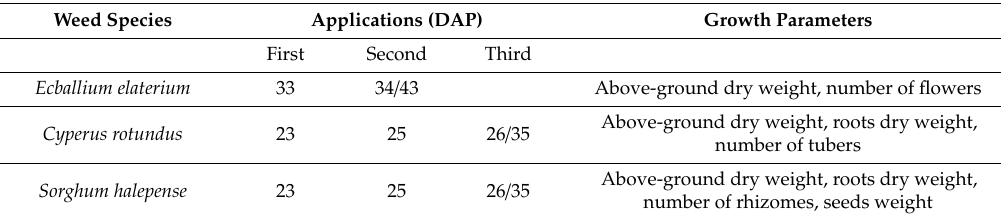
Table 1. Weed species, application timings (days after planting (DAP)) and evaluated growth parameters following the second \ third application on the perennial and invasive weeds.